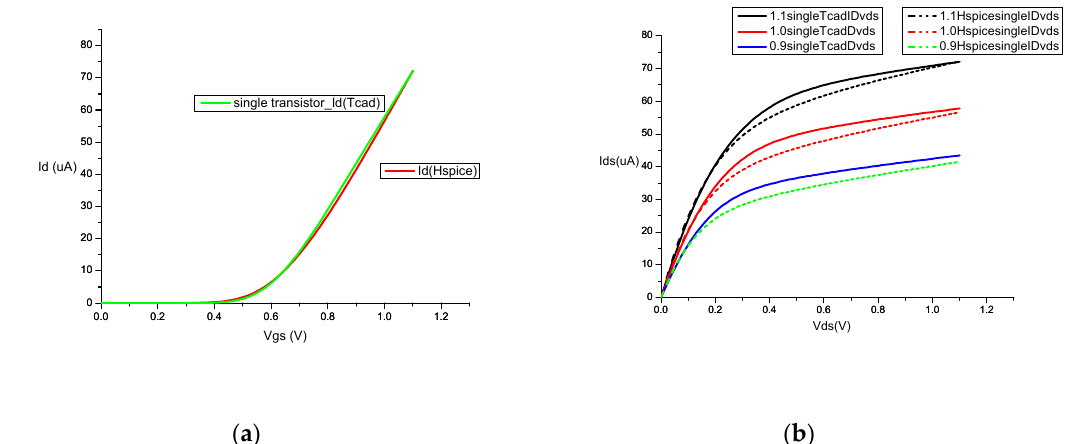
Figure 3. A single transistor: ( a ) I d –V g curves calibrated, ( b ) I d –V d curves calibrated.